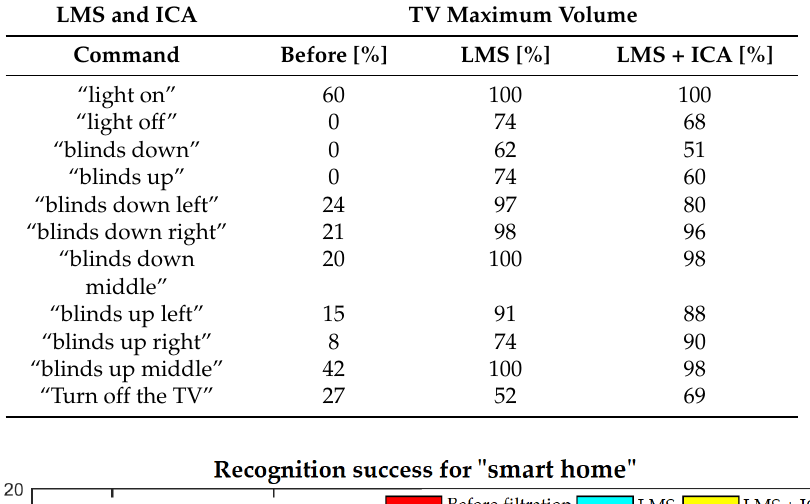
Table 10. The results of recognition success rate for vacuum cleaner interference.